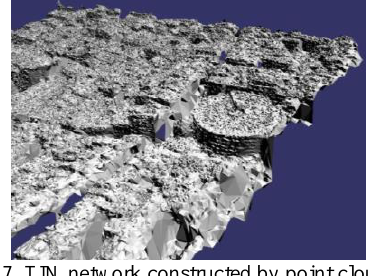
Fig 7. TIN network constructed by point cloud